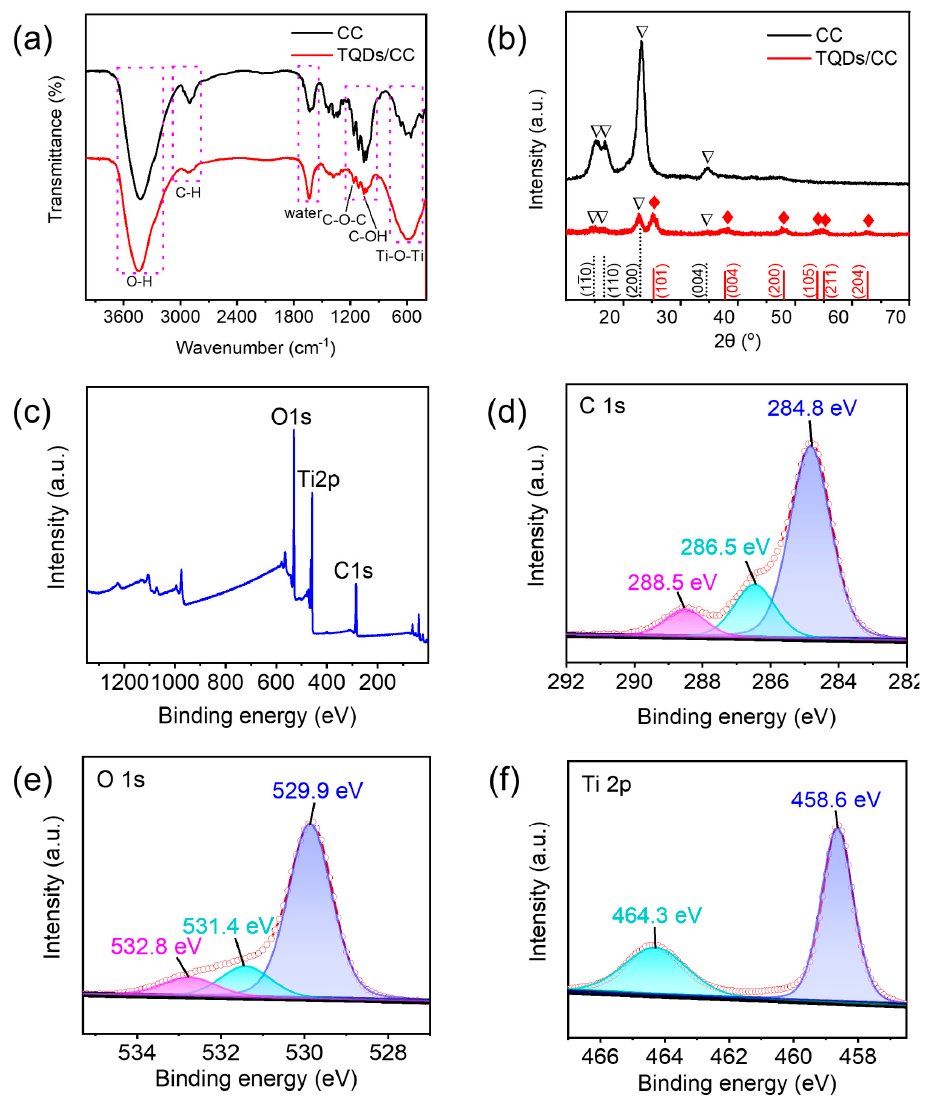
Figure 4. ( a ) FT-IR spectra and ( b ) XRD patterns of CC and TQDs/CC samples (Triangle represents peaks of cellulose and rhombus represents peaks of anatase TiO 2 ). XPS survey ( c ), high-resolution C 1s ( d ), O 1s ( e ), and Ti 2p ( f ) XPS spectra of TQDs/CC.